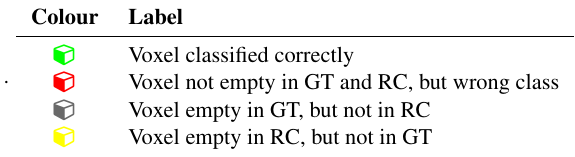
Table 4. The meaning of the colours in Figure 4 (GT: Ground truth, RC: reconstruction)